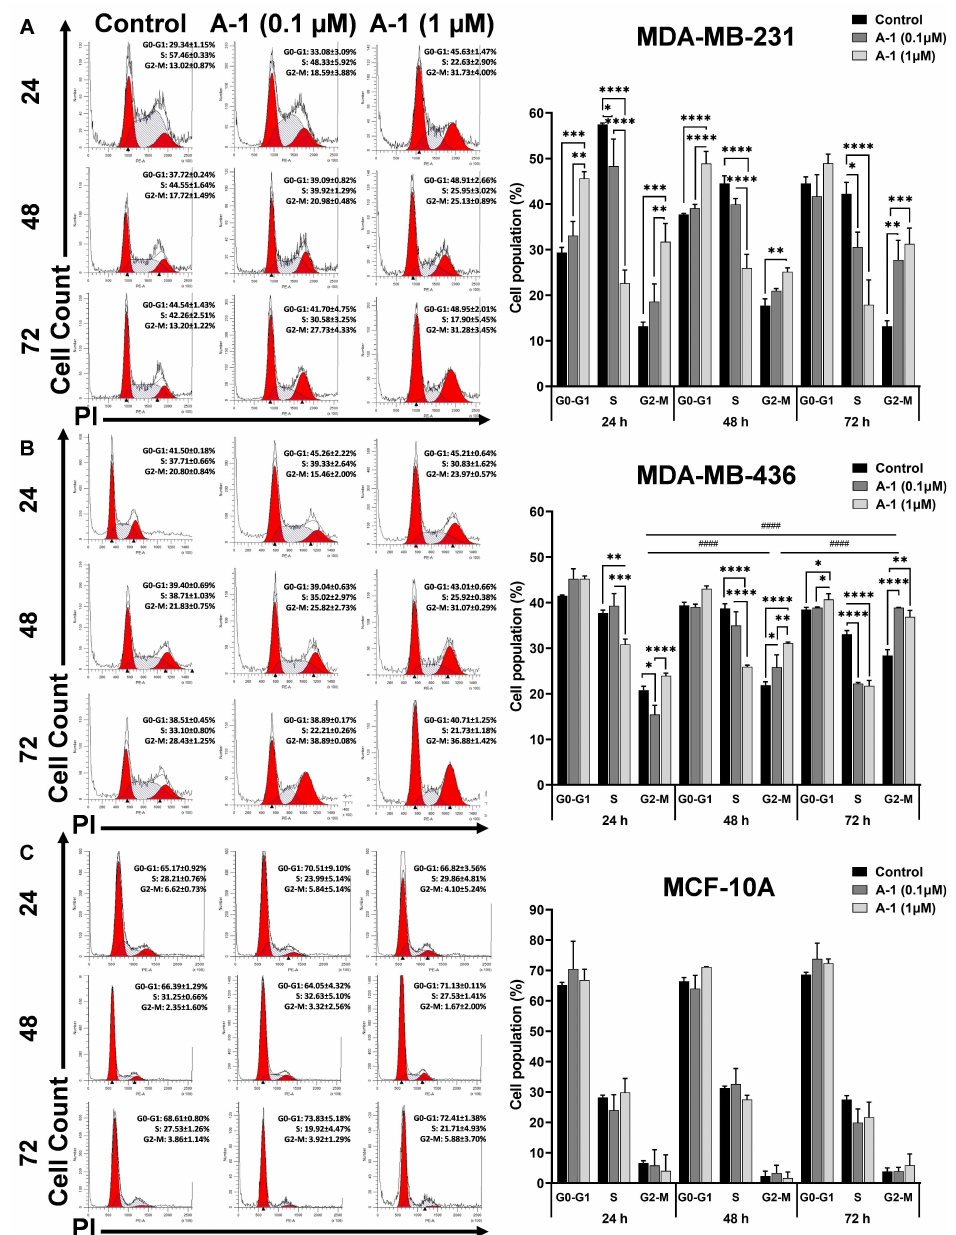
Figure 4. Effect of arachidin-1 (A-1) on cell cycle in MDA-MB-231 and MDA-MB-436 cells. Cells were treated with A-1 (0.1 and 1 µ M) for 24, 48, and 72 h. Each histogram represents one of three experiments performed independently. ( A ) MDA-MB-231, ( B ) MDA-MB-436, and ( C ) MCF- 10A-treated cells. Control groups were cells with 0.01% DMSO only. Data shown represent the mean ± SD from three replicates. * p < 0.05, ** p < 0.001, *** p < 0.0001 **** p < 0.00001 versus control, and ns = not significant from